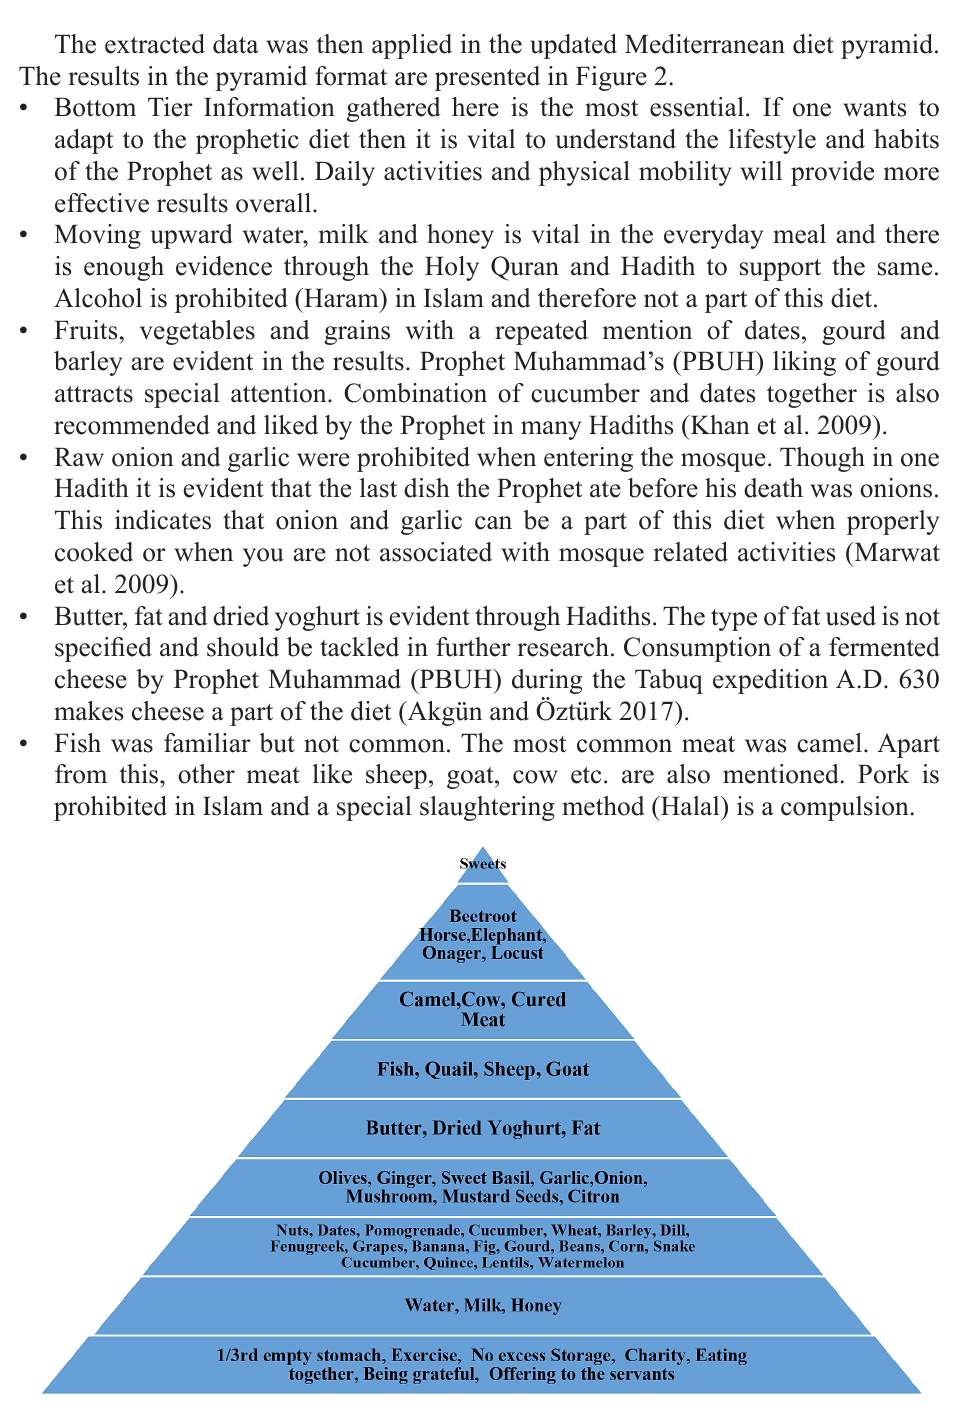
Figure 2. New prophetic food